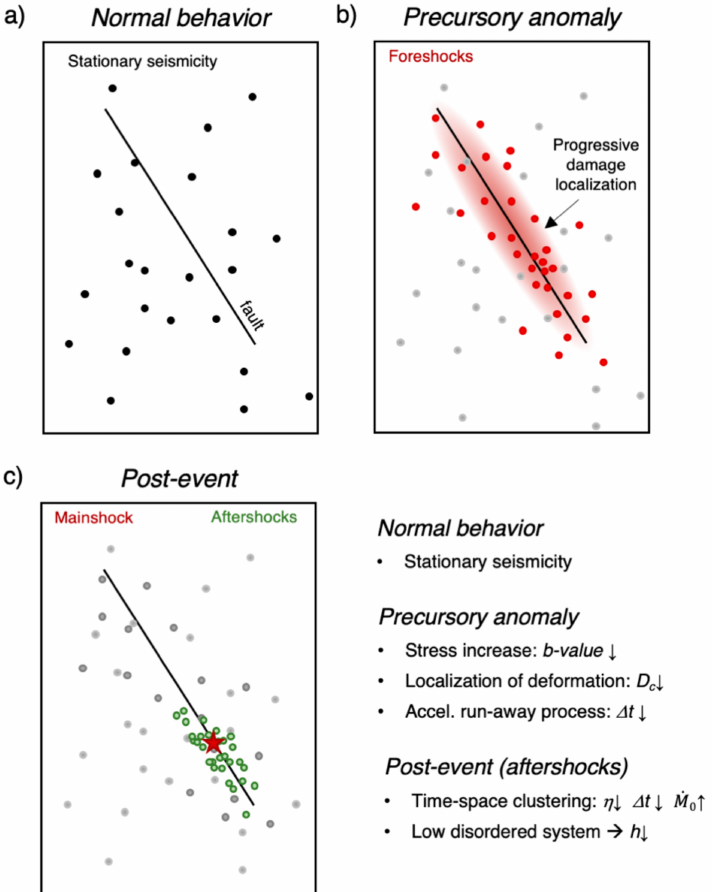
Figure 1. Schematic illustration of the processes anticipating and following a large earthquake. ( a ) Normal behavior phase, during which the seismicity shows a spatio-temporal stationary nature. ( b ) Precursory anomaly phase, during which the localization of deformation proposed by Kato and Ben-Zion, 2020 [26], occurs. Seismicity can show b-value , fractal dimension ( D c ), and seismic-rate ( ∆ t ) decrease. ( c ) Post-event phase, during which the seismicity is characterized by time-space clustering . M 0 , increase) and the system (i.e., ∆ t and generalized-distance, η , decrease, while moment-rate, shows high order (Shannon entropy, h ,